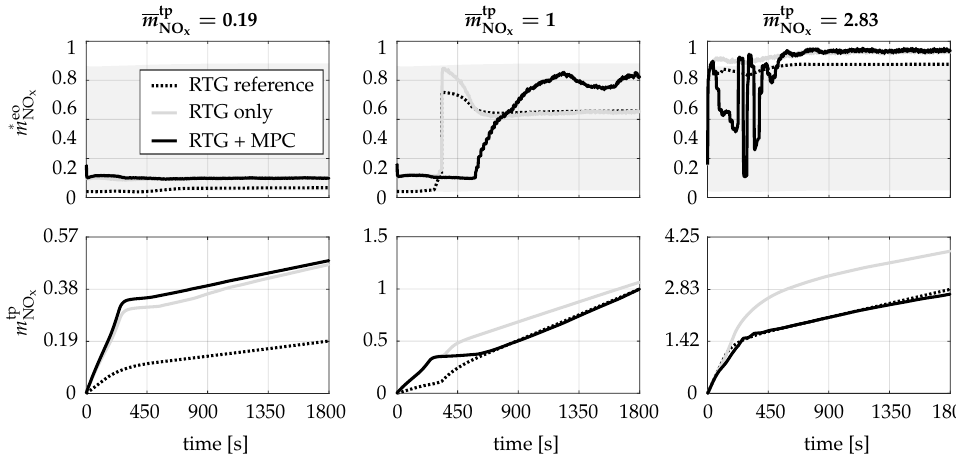
Figure 9. Resulting trajectories for the constant operating point cycle for different NO x limits. The gray regions in the upper row of plots show the modeled feasible range for the engine-out NO x mass flow. The dotted black trajectories were obtained by the RTG optimization. The solid gray trajectories show the measured operation with only the RTG, i.e., without feedback from the MPC. The solid black trajectories show the measured operation with the full predictive supervisory controller, i.e., with feedback from the MPC. All values were